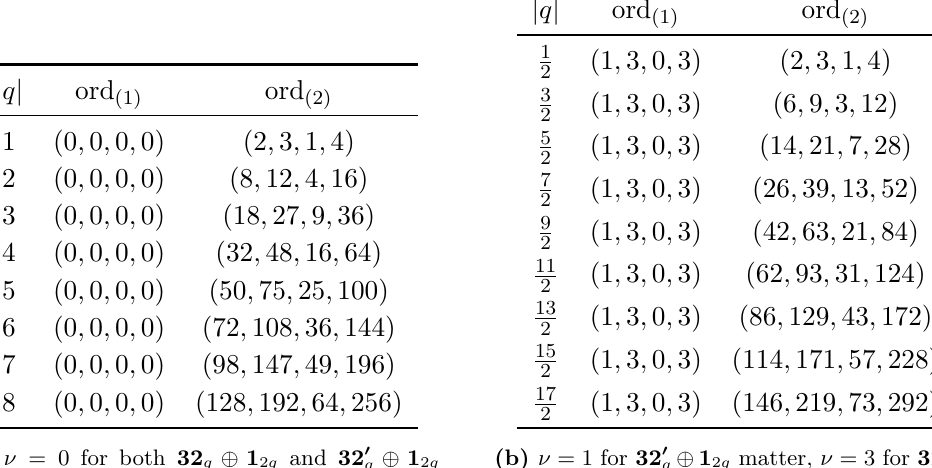
Table 17. Orders of vanishing of (ˆ x, ˆ y, ˆ z, ˆ w ) for various combinations of ν and pseudo-charges q for so (12) spinor matter. This matter occurs at codimension-two loci with I ∗ s The data are obtained using the so (12) ⊕ u (1) model in eq.